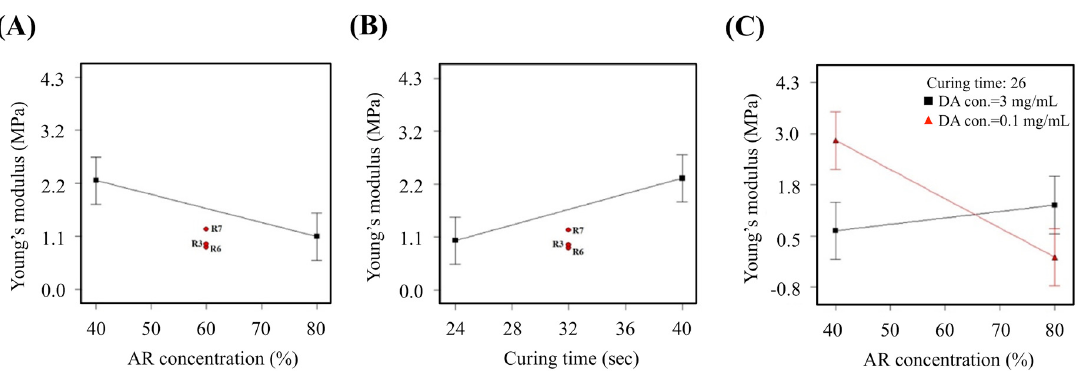
Figure 4. The main effect of ( A ) AR concentration, ( B ) curing time, and ( C ) AR-curing time-DA interaction on the Young’s modulus.